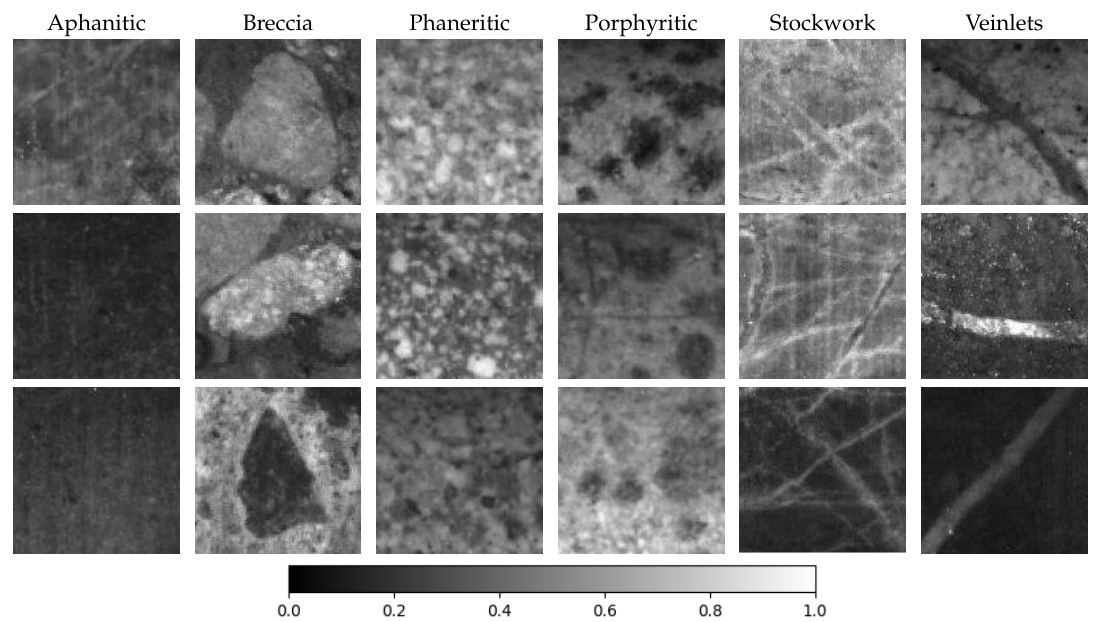
Figure 1. Examples from image rock texture database. Each class (presented in a separate column) was selected according to expert criteria, including geological structures and textures. Colormap: Images are presented in grayscale denoting for each class its specific visual characteristics (e.g., directionality, shape and sizes) which are described by its own spatial texture.